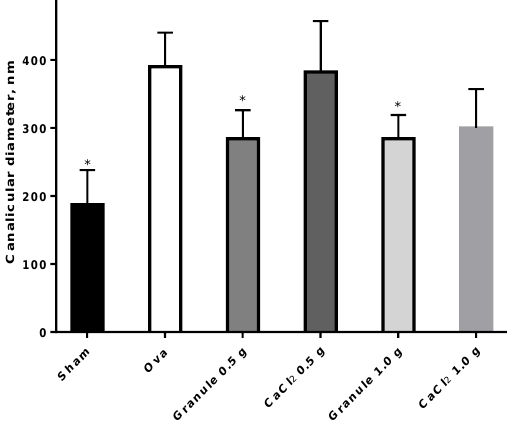
Figure 8. Canalicular diameters ± SD of rat femurs. * p < 0.05 versus Ova.